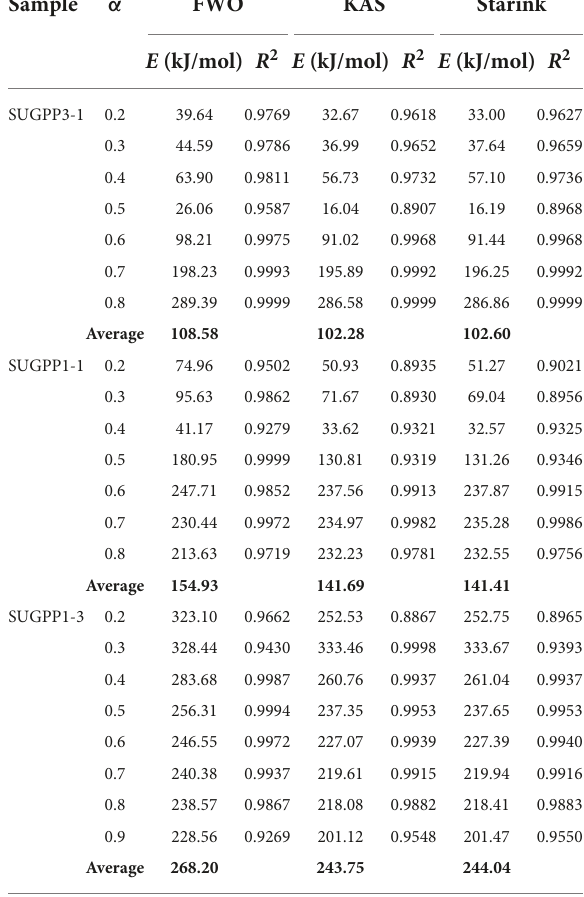
TABLE 6 Kinetics parameters of SUG and PP mixtures solved by isoconversional